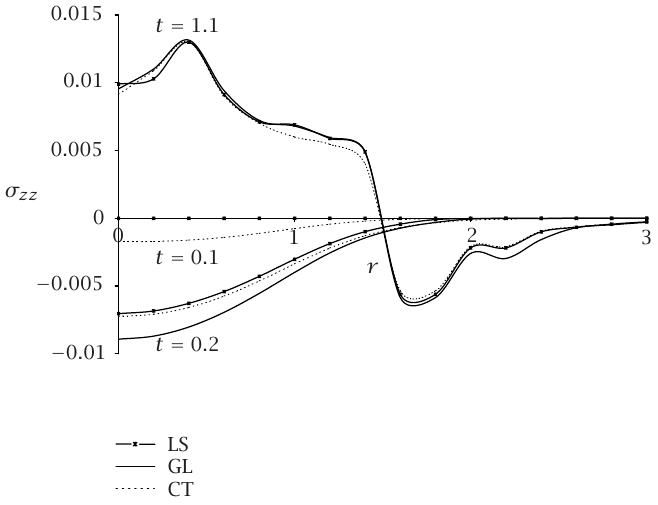
Figure 5.3. Axial stress distribution in the middle plane. Table 6.1. Propagating discontinuities in stress fields, where δ 1 = β 2 − 2 a 10 , δ 2 = − ( β 2 − 2 a 20 ), I 2